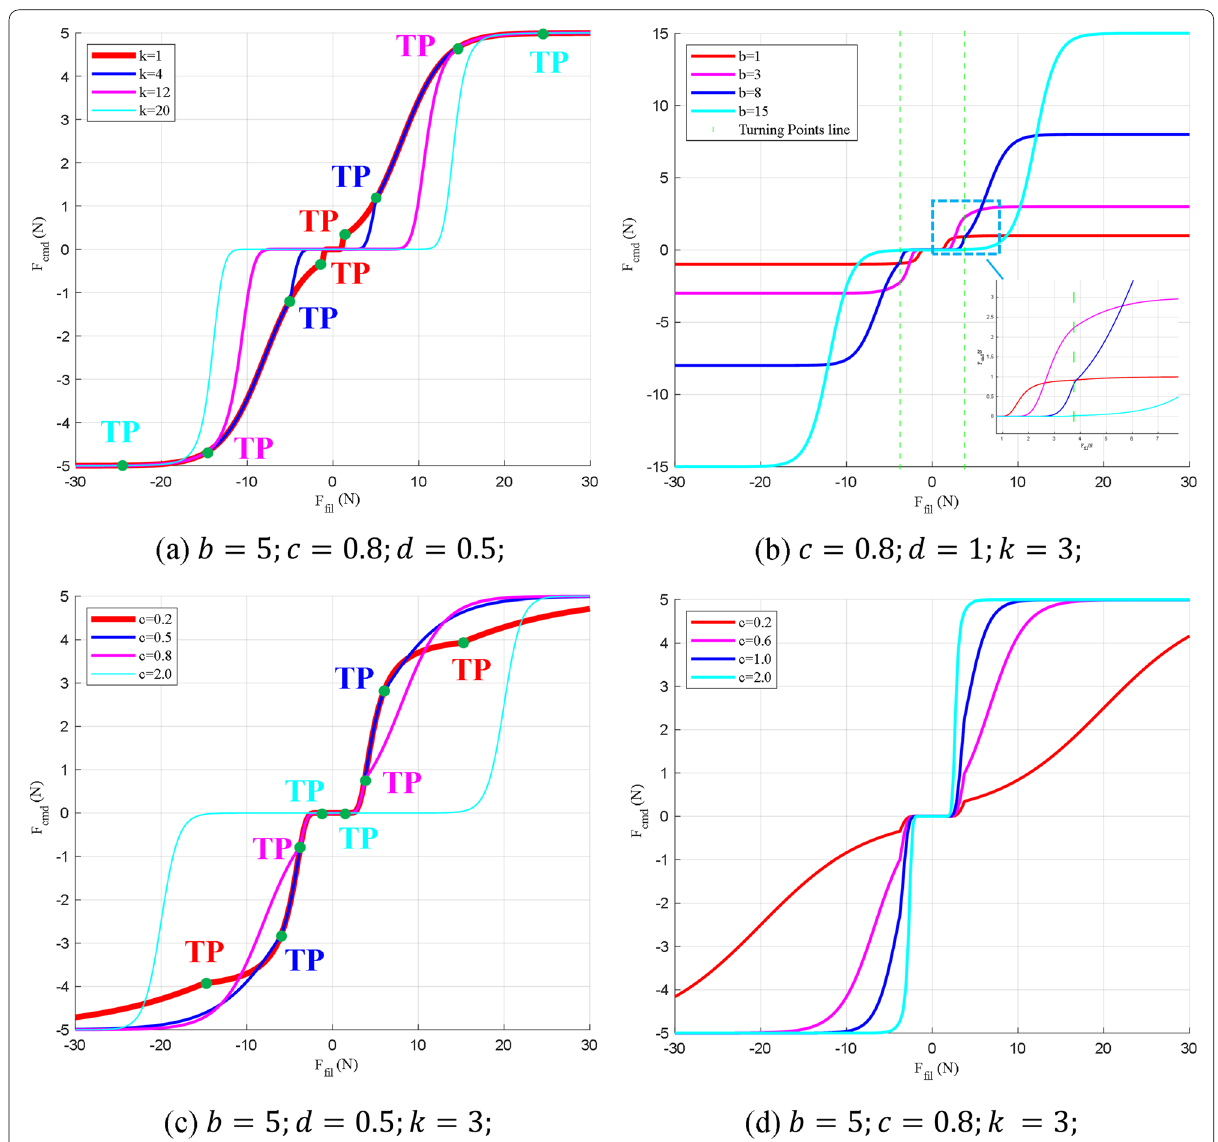
Figure 5 The effects of changing parameters on F